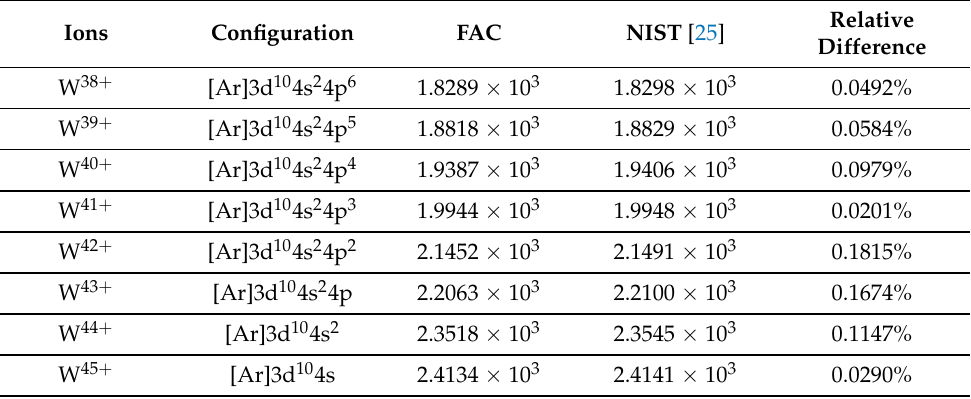
Table 2. Ionization potentials for W ions.